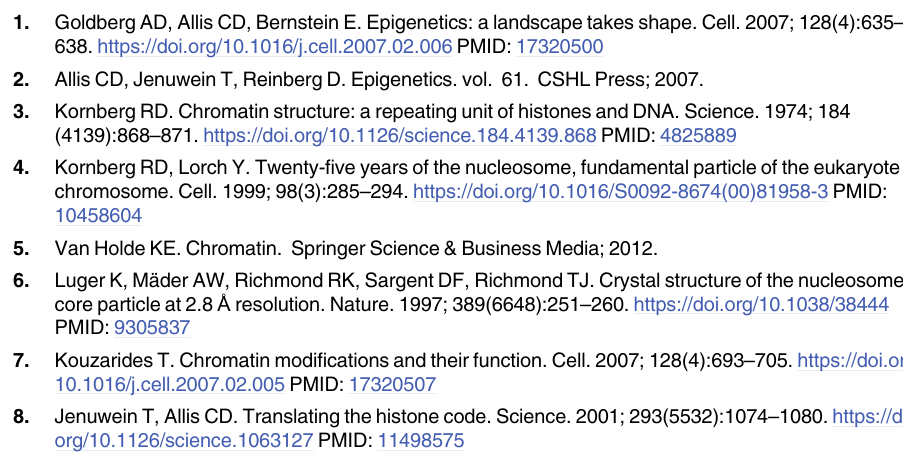
S3 Text. Discretization Algorithm, Experimental Data Simulation, Error across